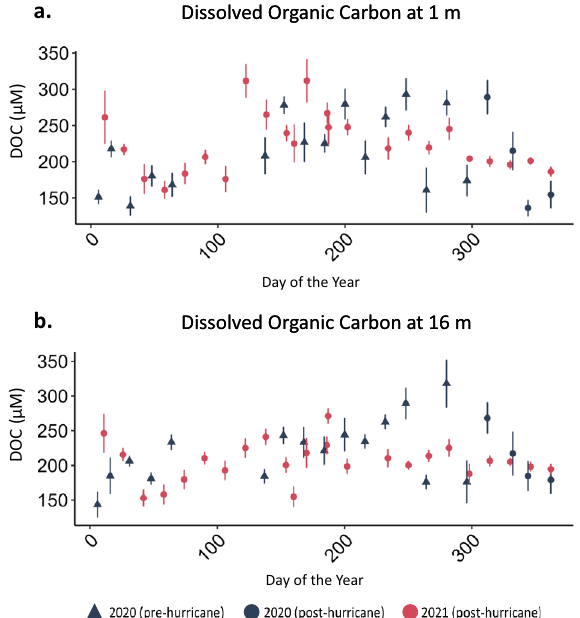
Figure 7. ( a ) Surface DOC, and ( b ) deep DOC at five continuously monitored in-lake locations (mean ±